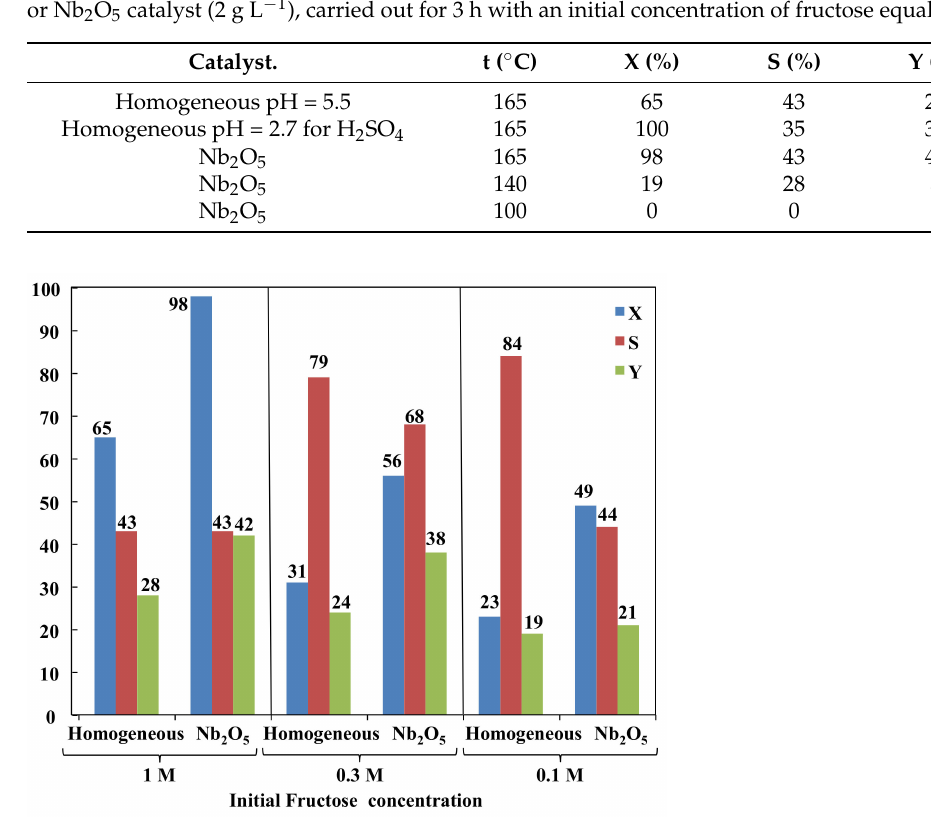
Figure 6. Fructose conversion ( X ), selectivity to HMF ( S ) and yield ( Y ) in different reactive conditions, i.e., in homogeneous regime at natural pH as well as in the presence of Nb 2 O 5 by using different initial concentration of fructose. Experiments were carried out at 165 ◦ C for 3 h by using 6 mL of fructose suspension. In the heterogeneous catalytic experiments, the Nb 2 O 5 amount was 2 g · L − 1